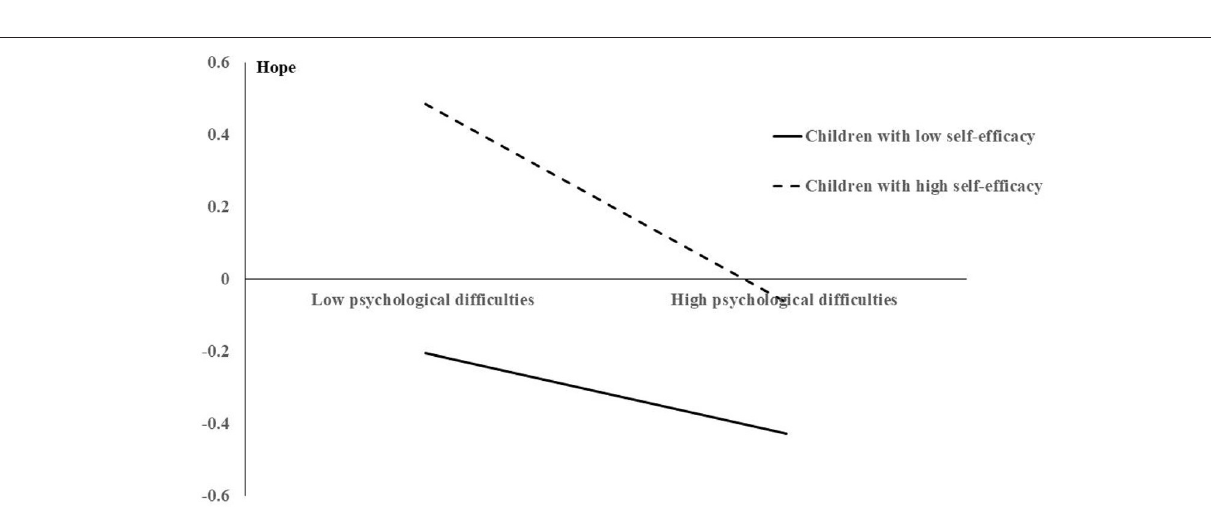
FIGURE 2 | The interaction between self-efficacy and psychological difficulties in predicting